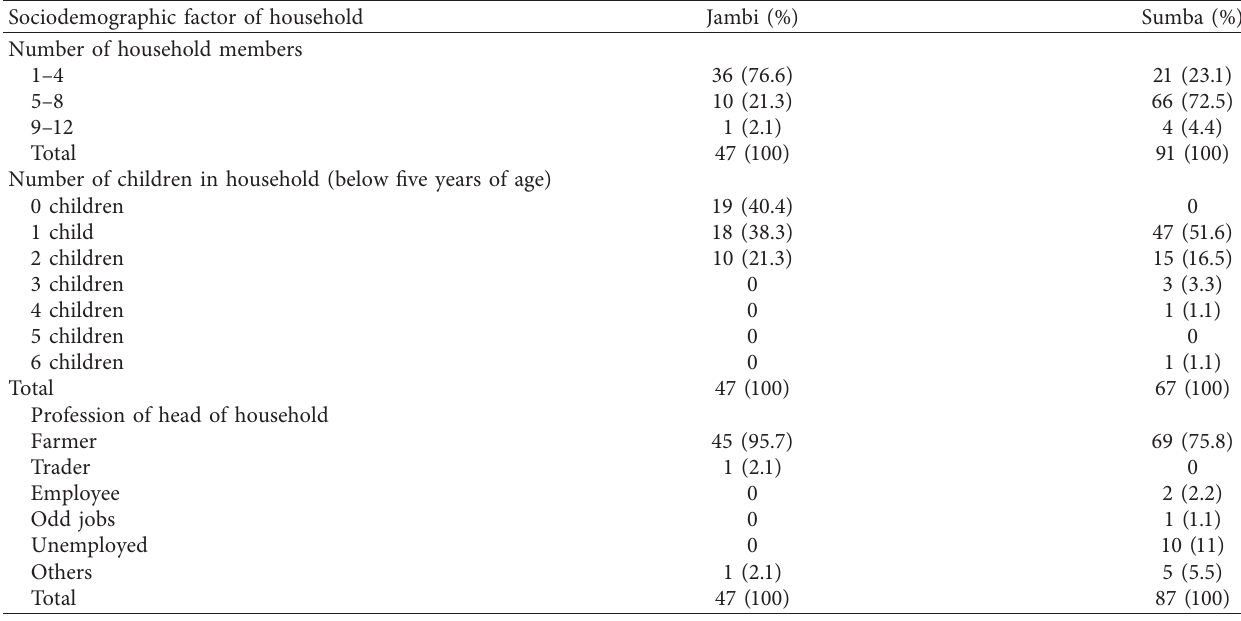
Table 2: The description of sociodemographic information of household in Jambi and Sumba.